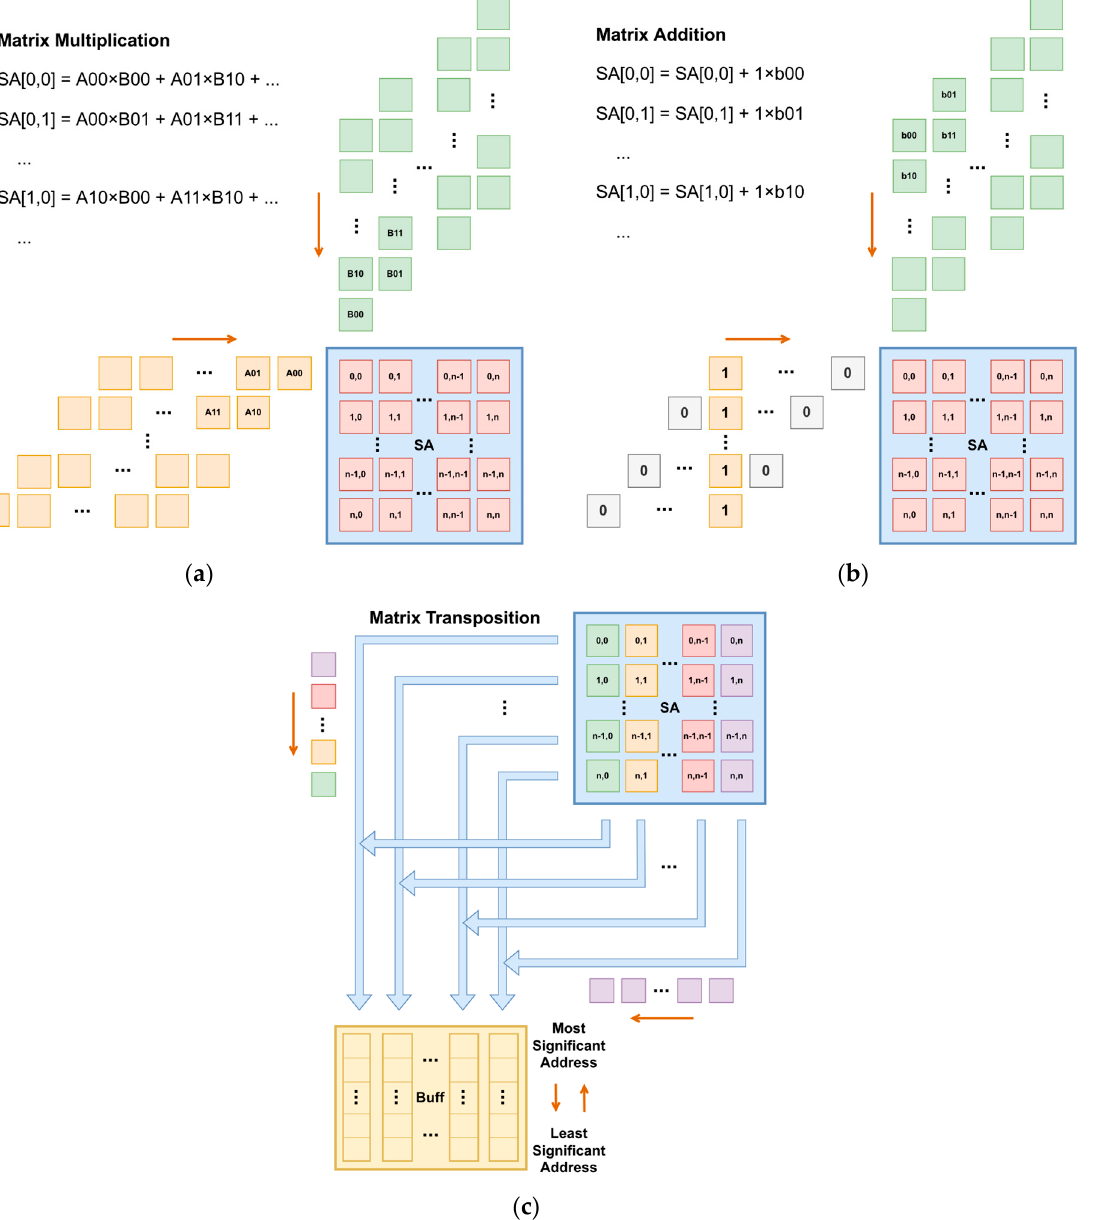
Figure 4. Data flow of the systolic array for ( a ) matrix multiplication, ( b ) matrix addition, ( c ) matrix transposition.